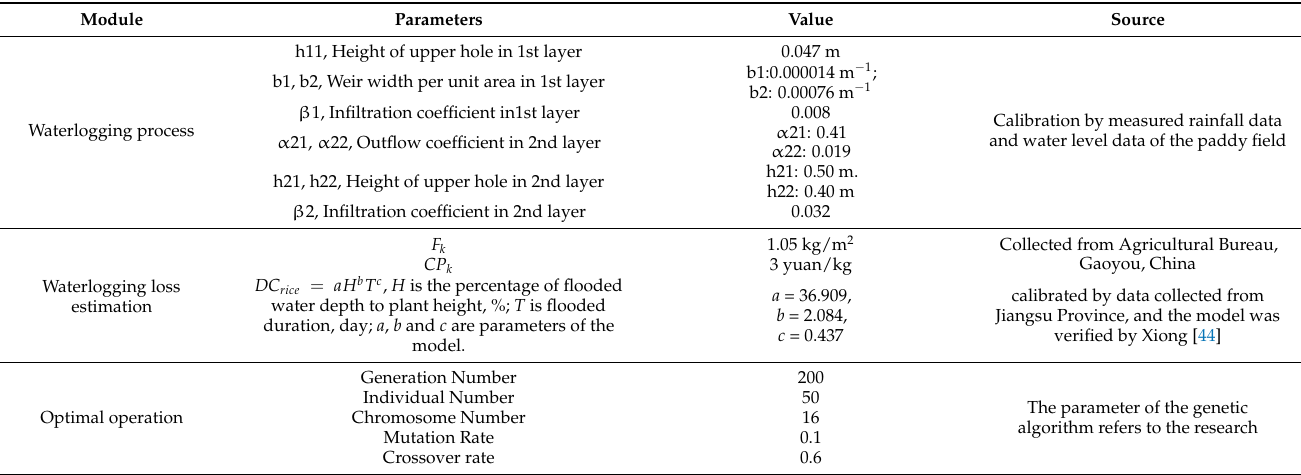
Table 1. Parameters in